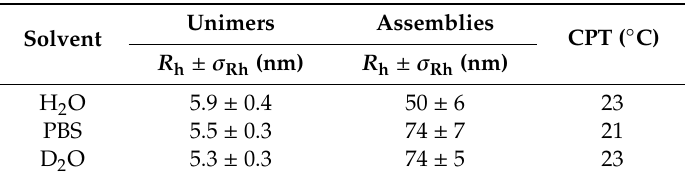
Table 2. Results of the normal distribution fit of peaks corresponding to unimers (U) and assemblies Table 1. Size values R h and their standard deviations σ Rh with regard to neighbouring measurements (A) in H 2 O, PBS and D 2 O describing the width of the individual population peaks with regard to their for unimers (U) and assemblies (A), and cloud point temperatures (CPT) of HF polymer in H 2 O, D 2 O means μ . and PBS based on DLS measurements.